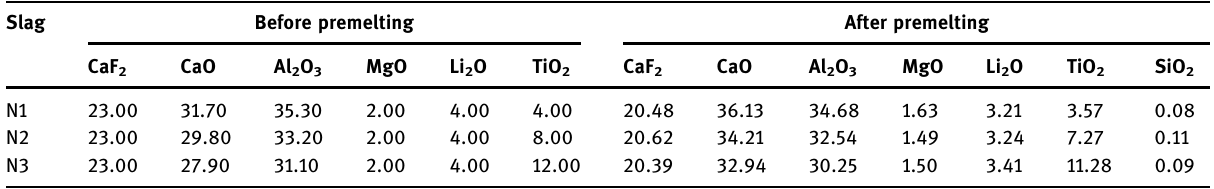
Table 3: Chemical composition of the slag before and after premelting ( % )